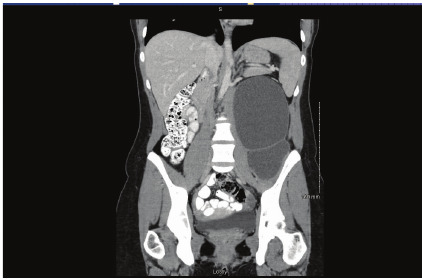
Figure 1: Computed tomographic scan showing a large retroperi- toneal mass with cystic and solid components.